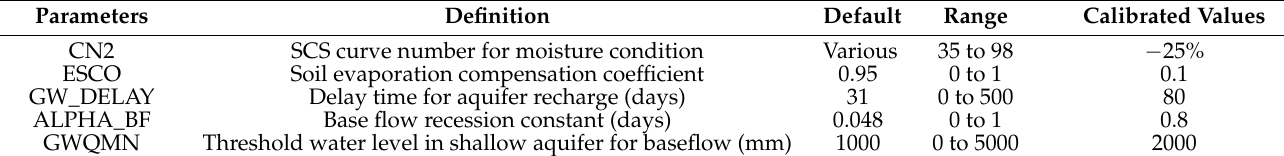
Table 3. Selected value for explanation and calibration of Soil and Water Assessment Tool (SWAT) model parameters. Parameters